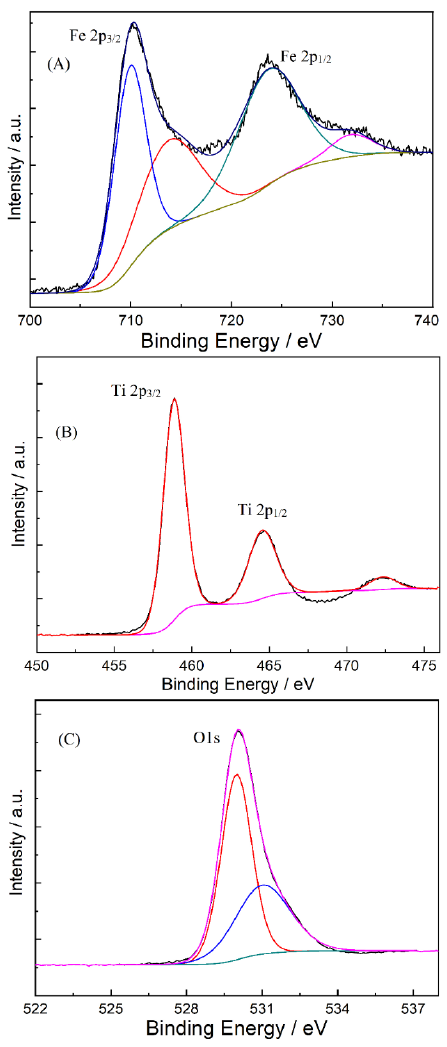
Figure 4. XPS spectra of Fe (2p) ( A ), Ti (2p) and ( B ) O (1s) ( C ) present in Fe 9 TiO 15 @TiO 2 . Catalysts 2020 , 10 , x FOR PEER REVIEW